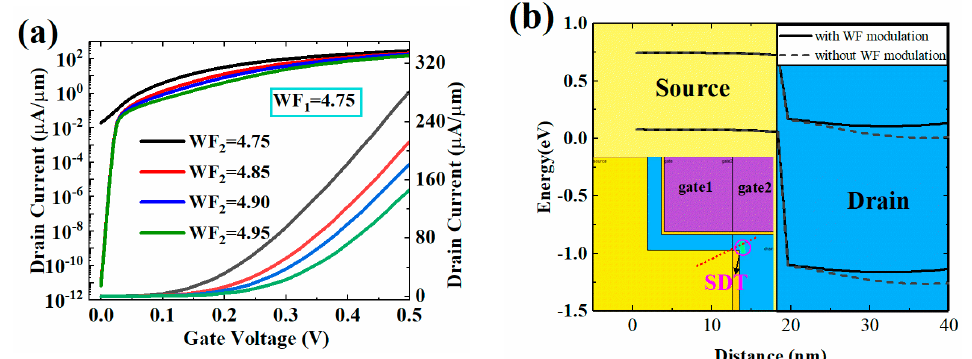
Figure 10. ( a ) Transfer characteristic and ( b ) band diagram with work-function modulation.